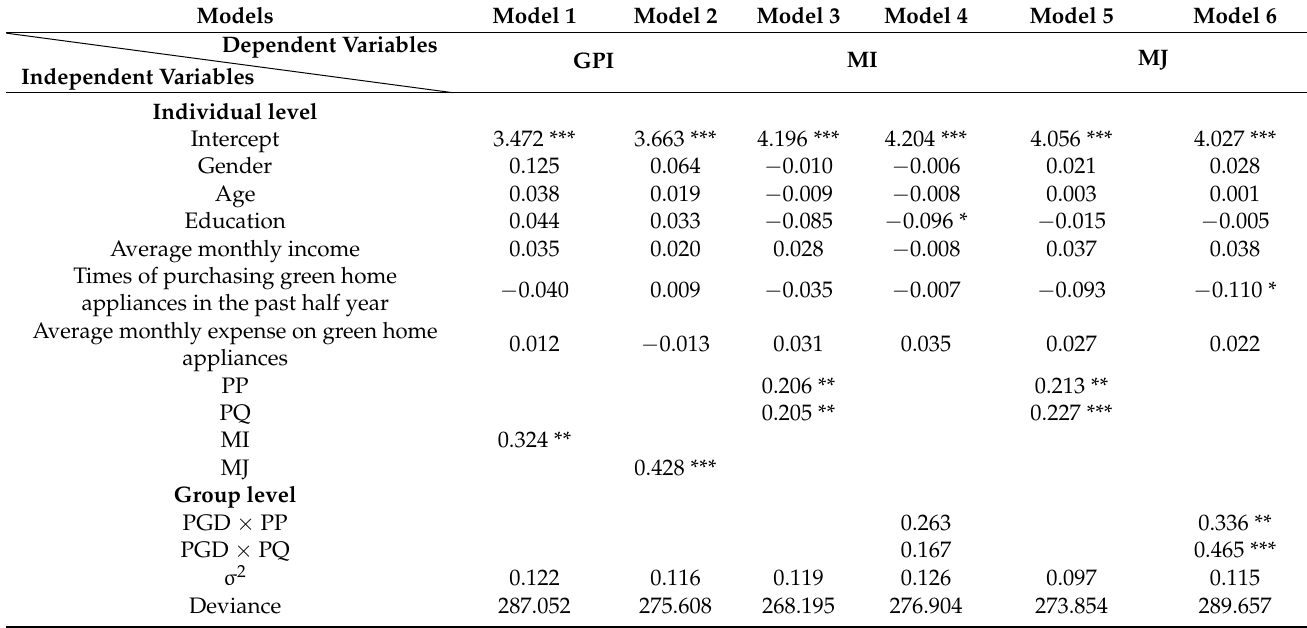
Table 4. Cross-hierarchy analysis results.